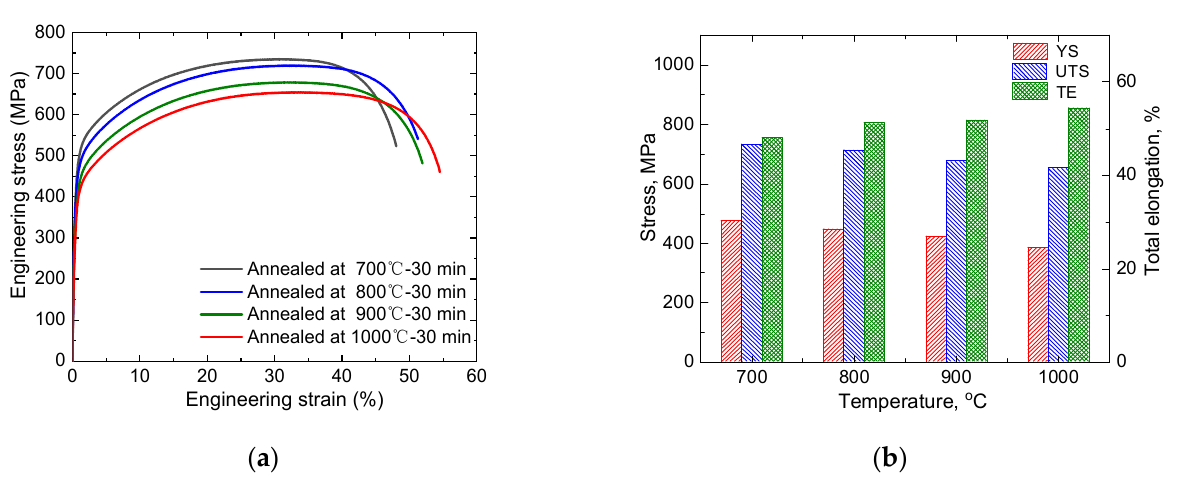
Figure 3. ( a ) Engineering stress–strain curves and ( b ) mechanical properties of the cold-rolled steel annealed at 700–1000 °C for 30 min.